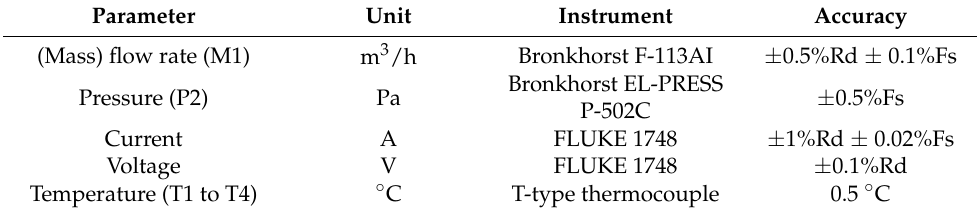
the flow rate refers to normal conditions of 0 ◦ C and 101.325 kPa